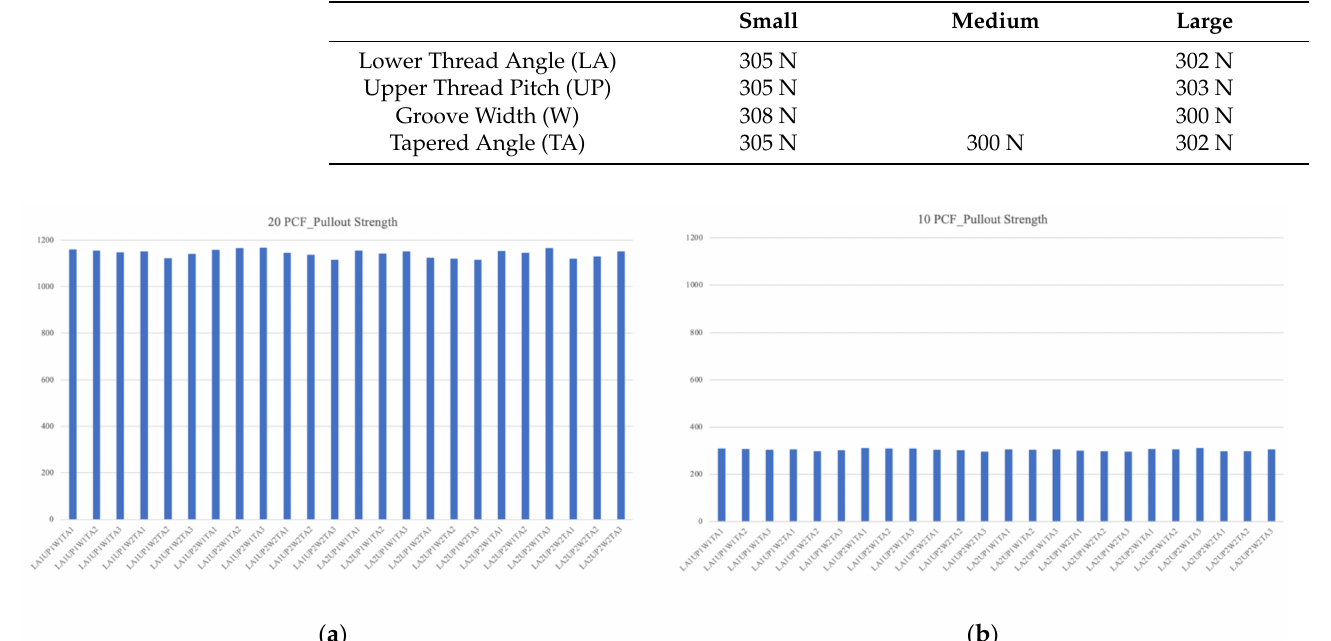
Table 3. Comparison of average pullout strength of four different design factors in 10 PCF.